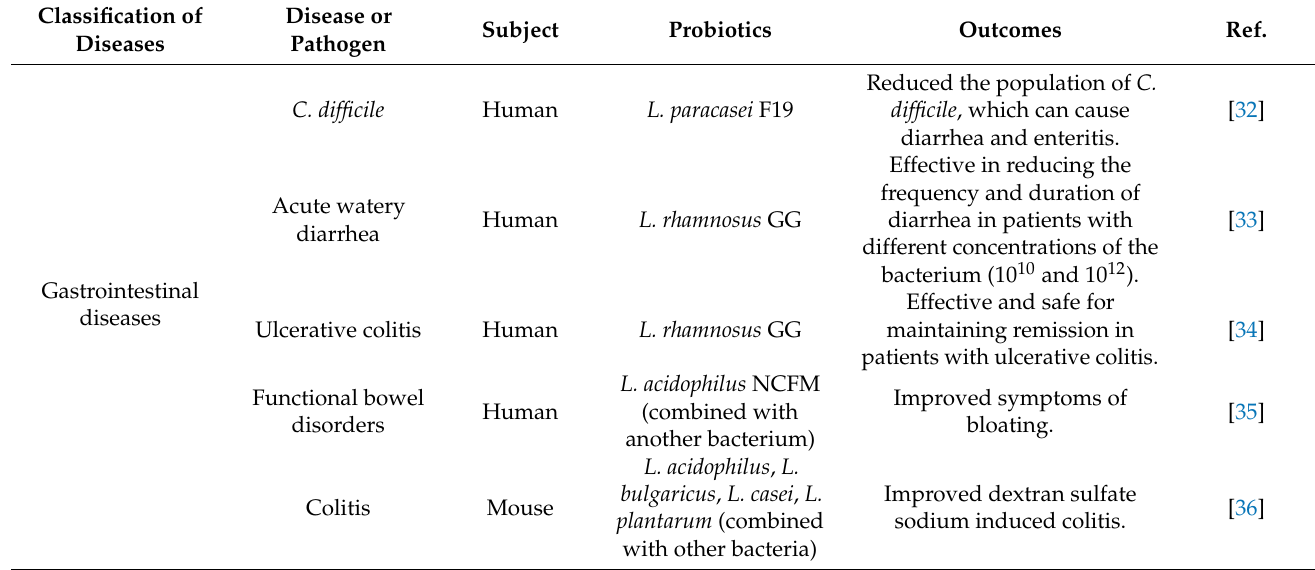
Table 1. Use of Lactobacillus as probiotics for various diseases. Classification